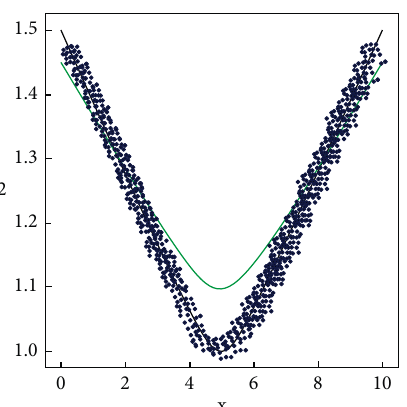
Figure 3: Finite population composed of quadratic functions.